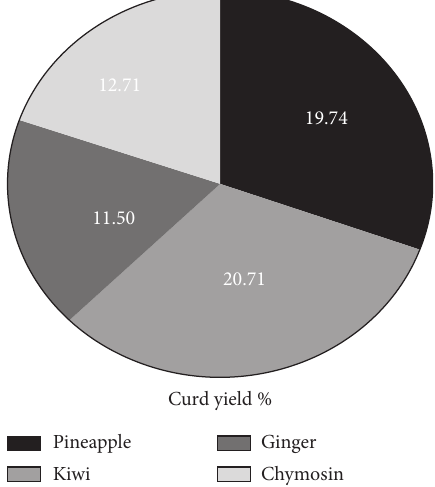
Figure 3: Curd yield (%) with different enzymatic extracts (chymosin, pineapple, kiwi, and Table 2: Physicochemical characteristics of camel’s cheese.